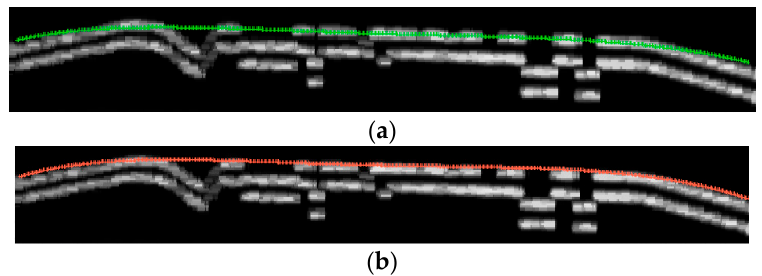
Figure 12. Fitted line estimation results for the ( a ) first line and ( b ) second line.